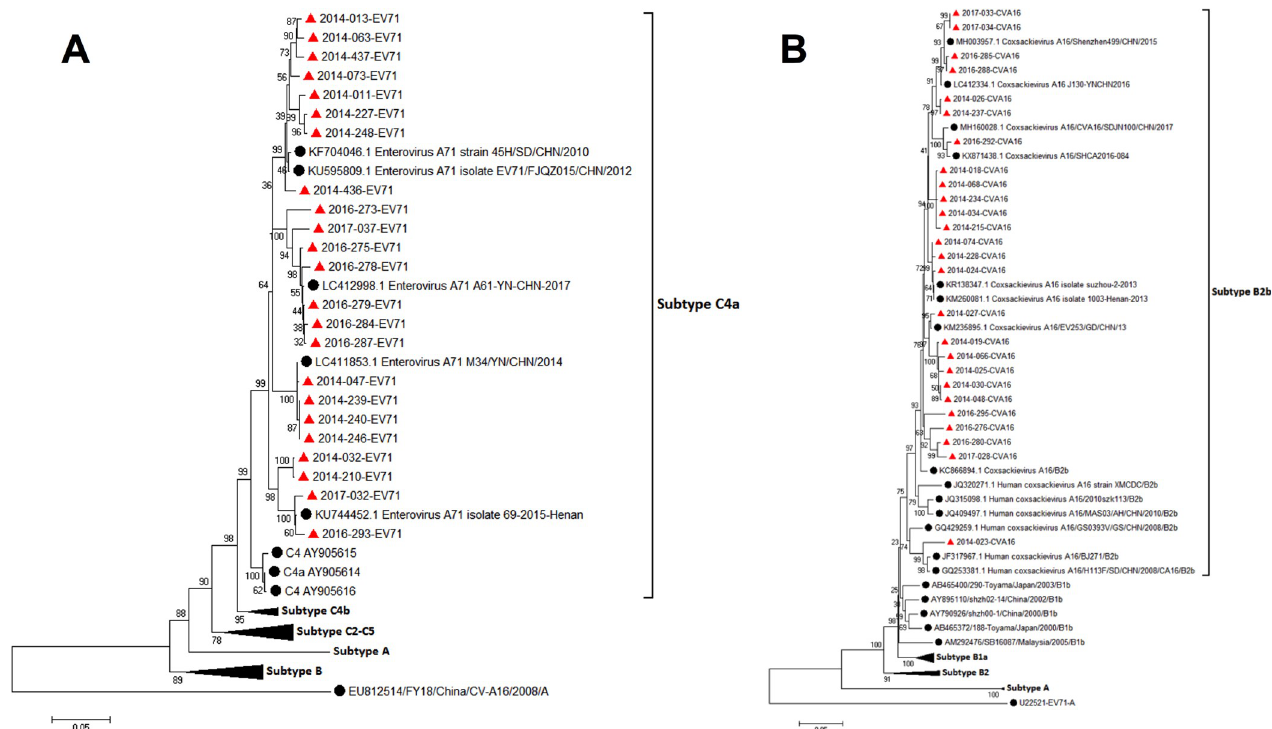
Fig 6. Phylogenic tree of EV71 (n = 23) and CV-A16 (n = 24) from Neijiang city. A) EV71; B) CV-A16; Red triangle, sequences from Neijiang city; Black sphere, reference sequences.